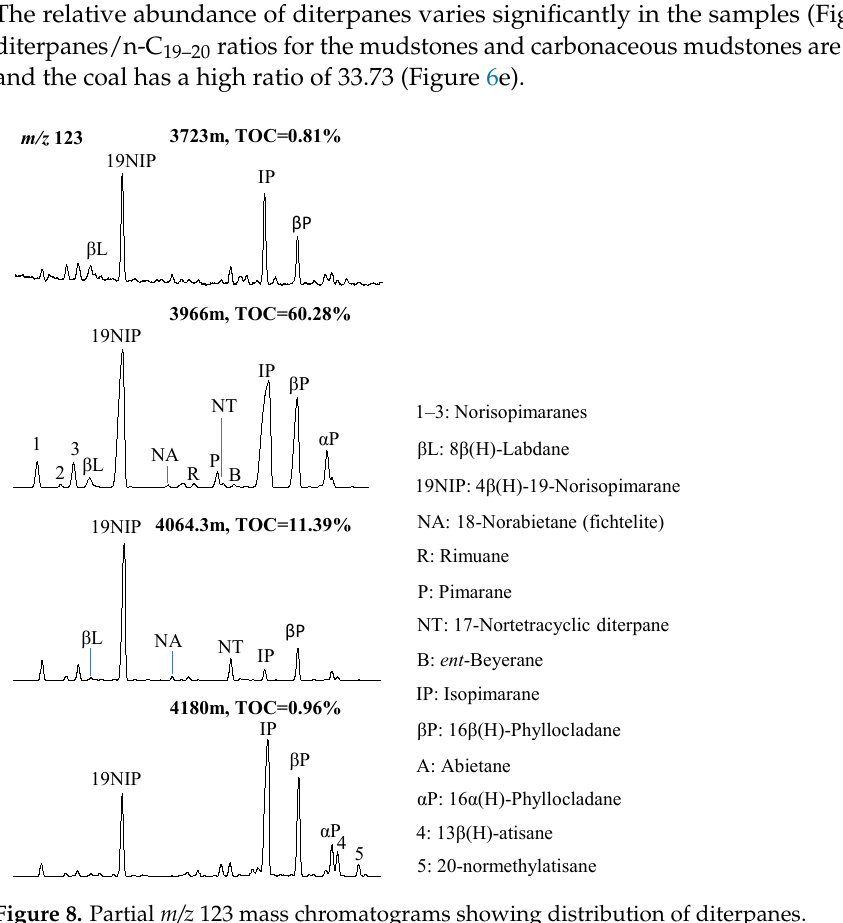
Figure 8. Partial m/z 123 mass chromatograms showing distribution of diterpanes.